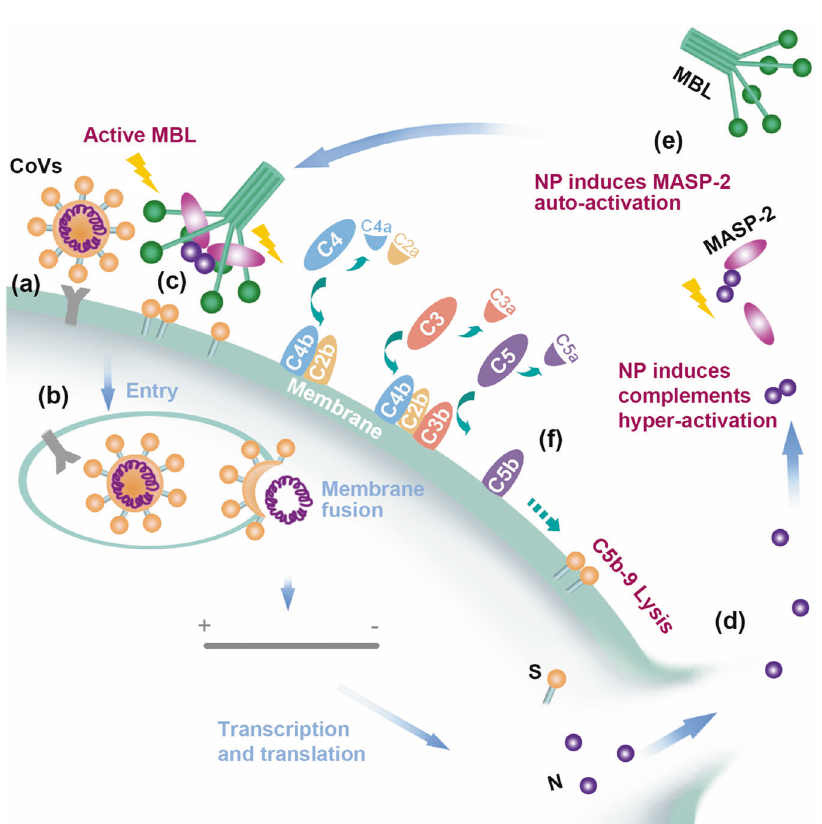
Fig. 7 Schematic representation of the MBL pathway overactivated by the N protein of SARS-CoV, MERS-CoV, or SARS-CoV-2. a Virus binds the host cell surface. b Virus enters host cells and expresses viral proteins, including S and N proteins. c The S protein activates MBL. d N protein is released by secretion or after cell or virus lysis. e Extracellular soluble N protein dimers interact with MASP-2 and promote MASP-2 autoactivation and binding to MBL. f The accelerated activation of MASP-2 induces downstream complement cascade overactivation of the MBL